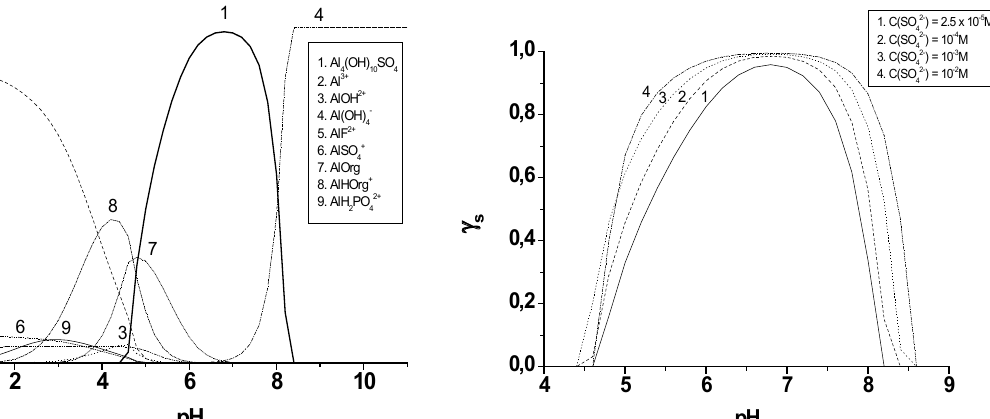
Figure 9. Distribution curves of the soluble species and solid Solute mole fraction (or the degree of precipitation) of basaluminite versus pH for the complexes AlOrg and